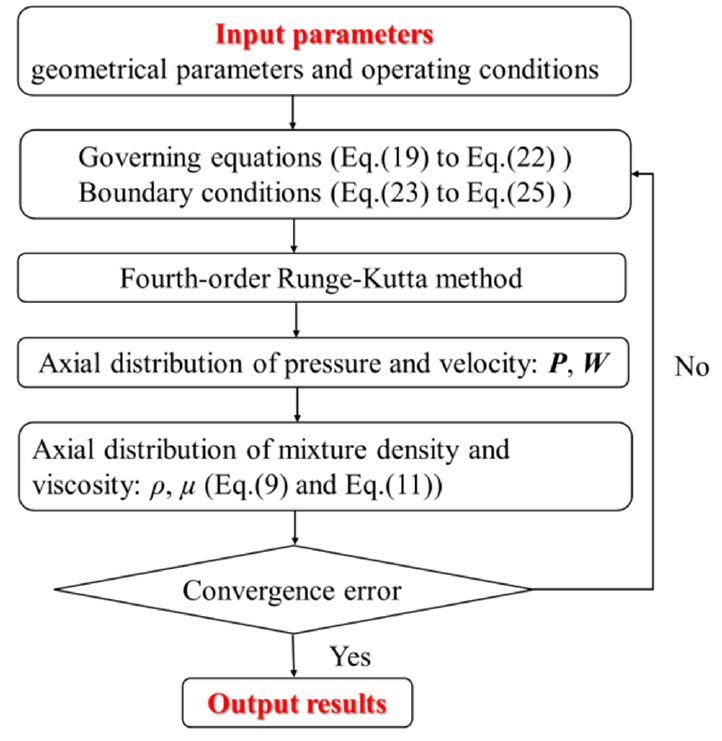
Figure 2. Program flow chart.